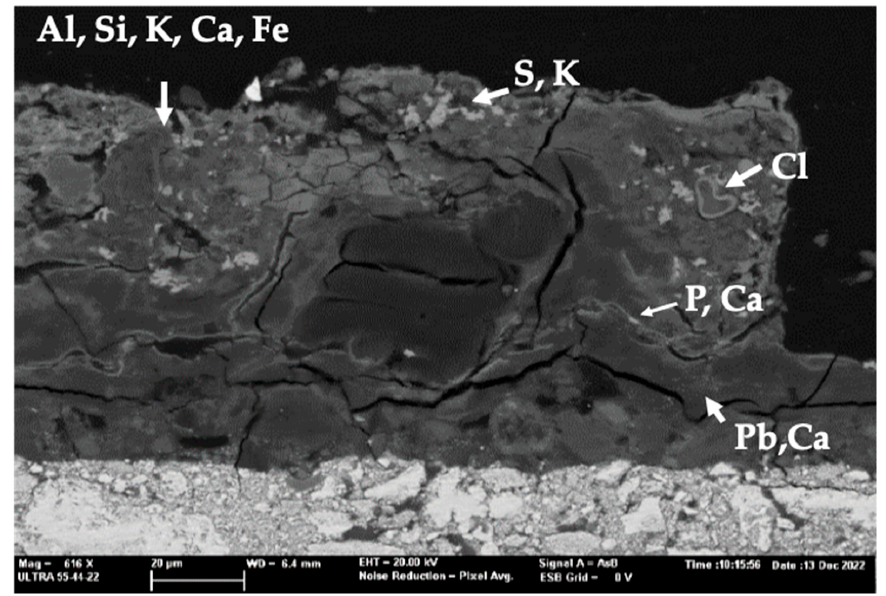
Figure 14. Altered varnish in sample C-4.